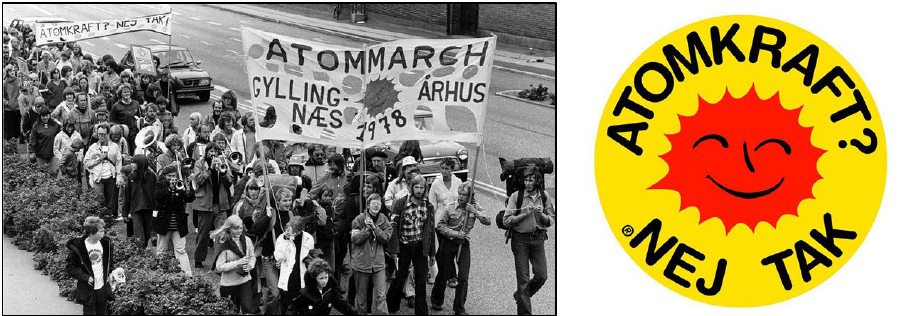
Figure 6. Left: public protest nuclear power. Right: the iconic “Nuclear Power? No Thanks” icon from the Danish anti-nuclear movement. Source: [55].